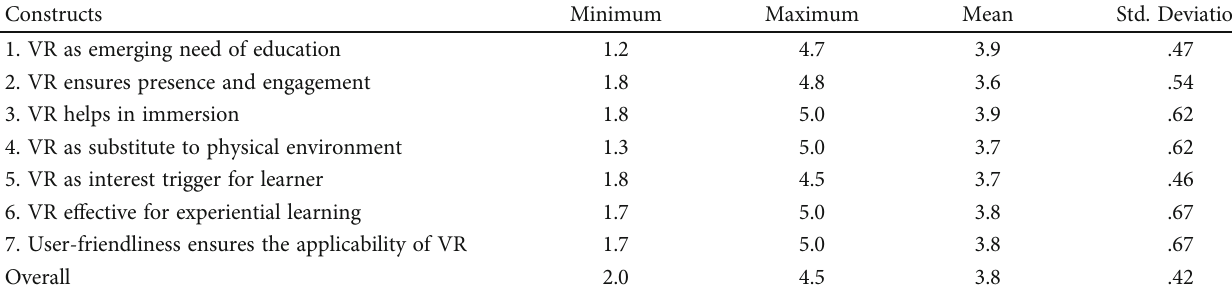
Table 3: Descriptive statistics of constructs.